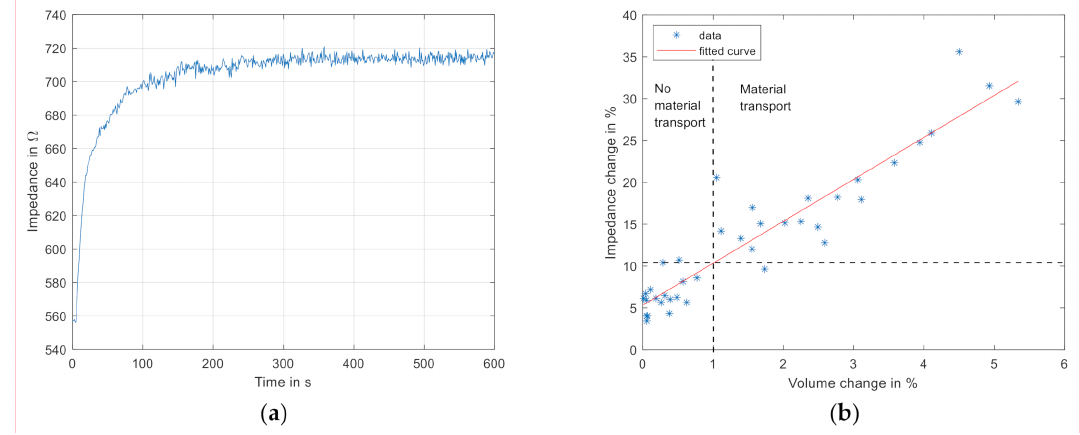
Figure 11. ( a ) Impedance over time at resonance frequency of measurement 6. ( b ) Impedance change over volume change for 39 individual measurements with a fitted